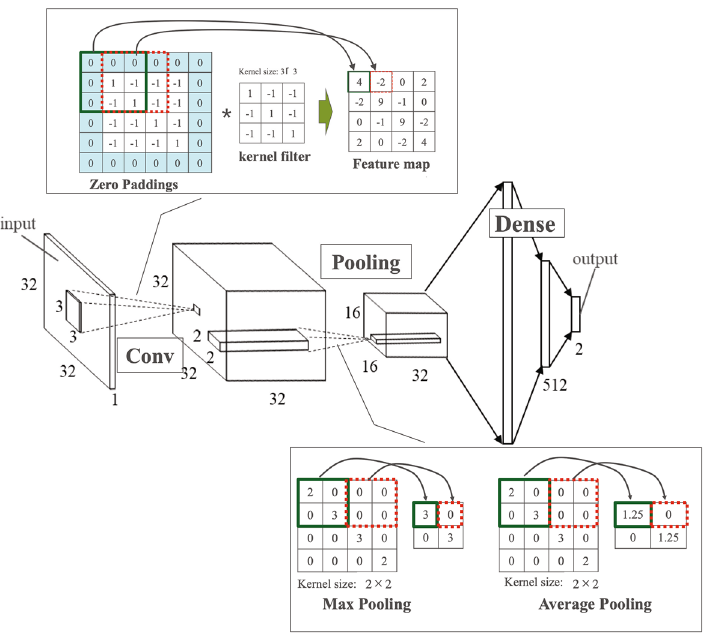
Figure 4. Configuration of CNN. The figure numbers represent the pixel size of the image. Conv performs convolution processing on the image data converted into a cubic matrix of red/green/blue (RGB) and extracts the feature